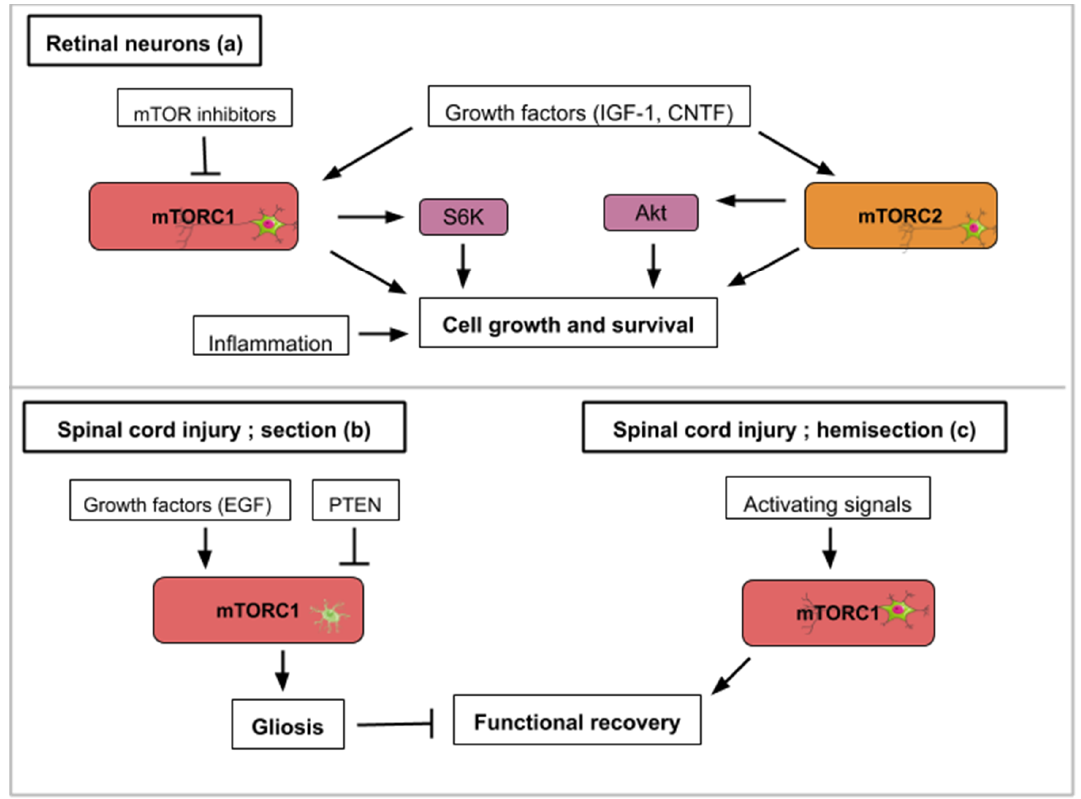
Figure 3. This figure illustrates how activity from the mTOR signaling pathway contributes to axon regeneration in the selected examples of retinal nerve damage ( a ) and spinal cord injury ( b , c ): ( a ) Concerning retinal nerve regeneration, mTOR activity enhances axon elongation and survival leading to functional regeneration. Signals that upregulate mTOR activity like PTEN inhibition, siRTP801, Pam 3 Cys (pro-inflammatory signal), CNTF (ciliary neurotrophic factor) or IGF-1 lead to axon recovery. TOR-independent axon recovery exists however as rapamycin-treated PTEN-deleted neurons and Pam 3 Cys untreated neurons still showed recovery. ( b ) For spinal cord injuries, mTORC1 activity in astrocytes hinders neuronal recovery with the formation of glial scars (gliosis). Growth factors like EGF (epidermal growth factor) can activate mTORC1. ( c ) On the contrary, mTORC1 signaling in hemisection spinal cord injuries promotes growth and functional regeneration.